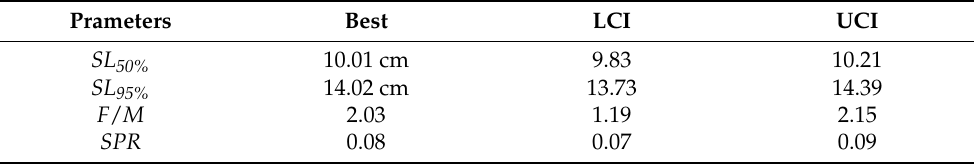
Table 5. Outputs form LB-SPR analysis with 95% confidence interval.